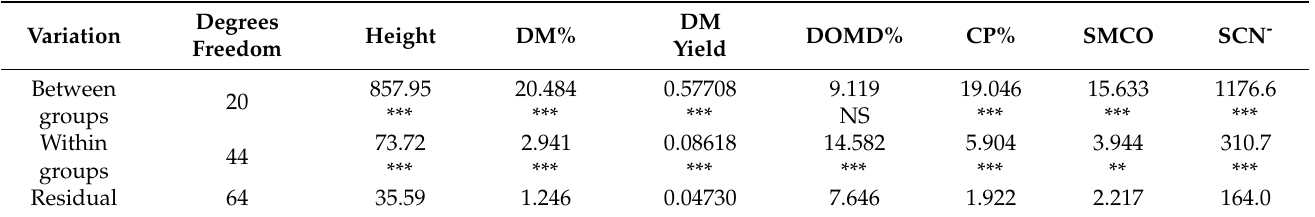
Table 1. Mean squares from analysis of variance and levels of significance for sources of variation where groups are 8 botanical varieties plus 13 hybrids.